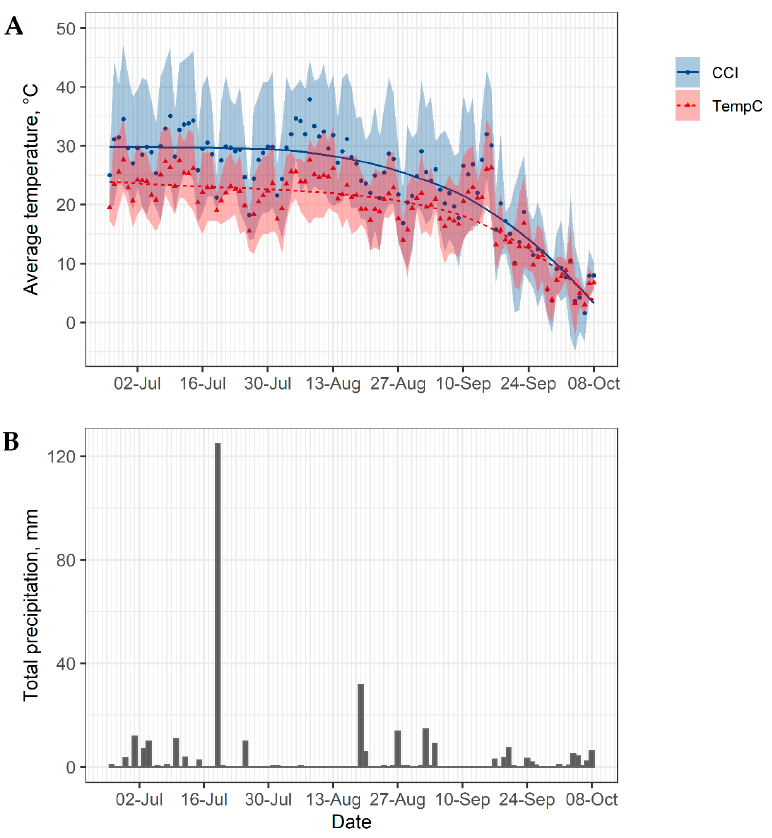
Figure 2. ( A ) Average daily ambient temperature and average daily comprehensive climate index (CCI; i.e., apparent temperature). Lines are the best fit locally estimated scatterplot smoothing (loess) regressions. Transparent bands represent daily minimum and maximum values. ( B ) Total daily precipitation.